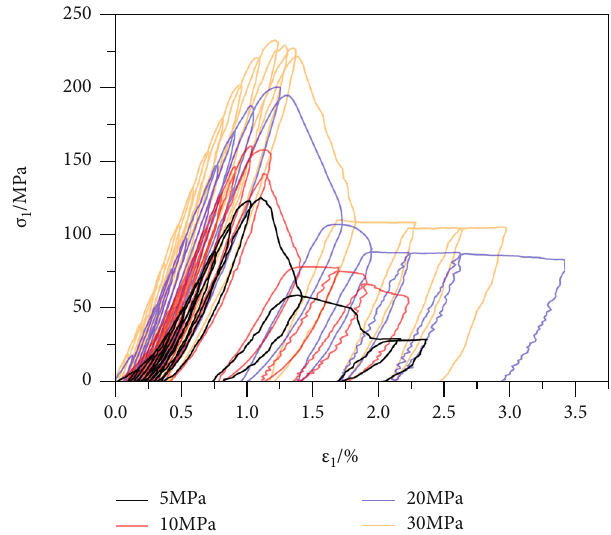
Figure 3: Stress-strain curves under cyclic loading and unloading